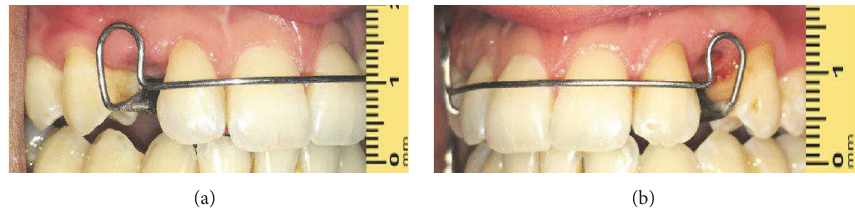
Figure 7: Intraoral view with removable orthodontic appliance showing missing teeth and diastema. (a) Right side. (b) Left side.